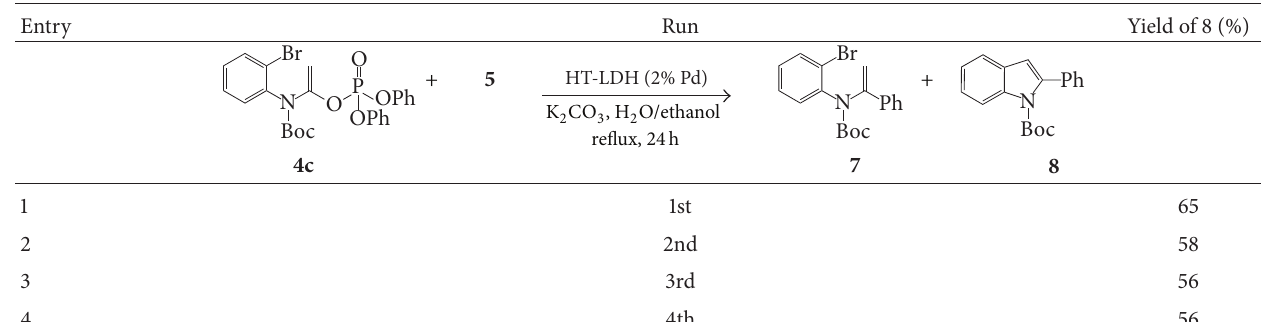
Table 3: Catalyst reusability 1